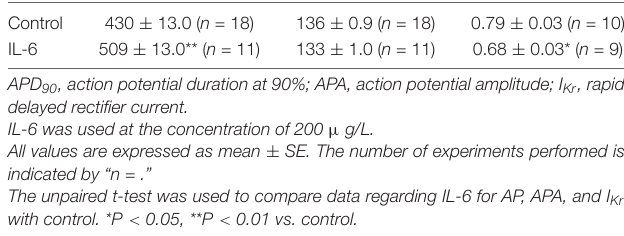
TABLE 4 | Effect of IL-6 on action potential and I Kr of guinea pig left ventricular myocytes.